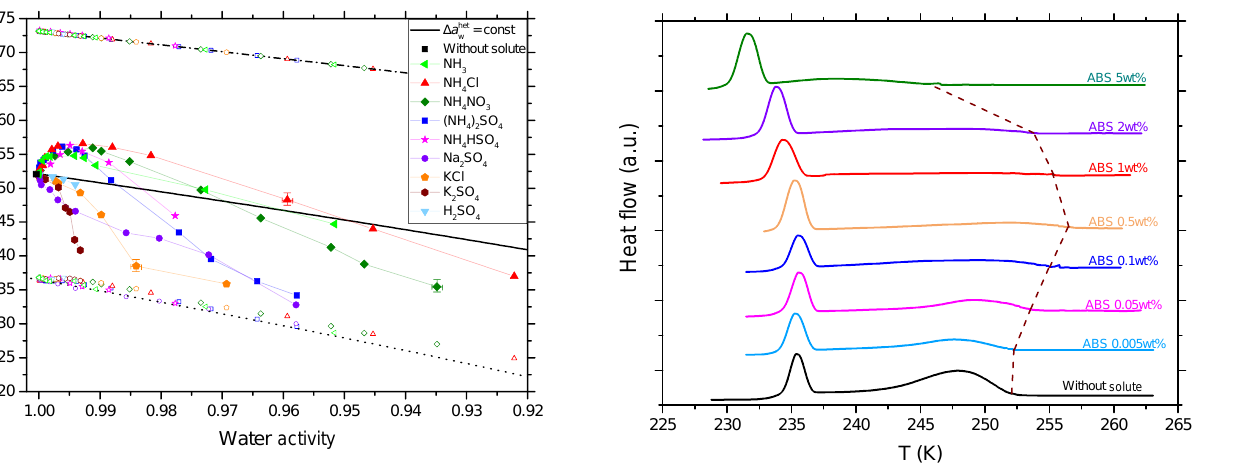
Figure 4. DSC thermograms of 2wt% of microcline particles sus- pended in ammonium bisulfate (ABS) solution droplets of vary- ing concentration (0–5wt% ABS). All curves are normalized such that the areas under the heterogeneous and homogeneous freezing curves sum up to the same value. The dashed line connects the heterogeneous freezing onset temperatures ( T het ) of the emulsions. With increasing ABS concentration, T het increases initially, then de- creases sharply. In contrast, the intensity of the heterogeneous freez- ing signal decreases monotonically, implying a continuous decrease in F het